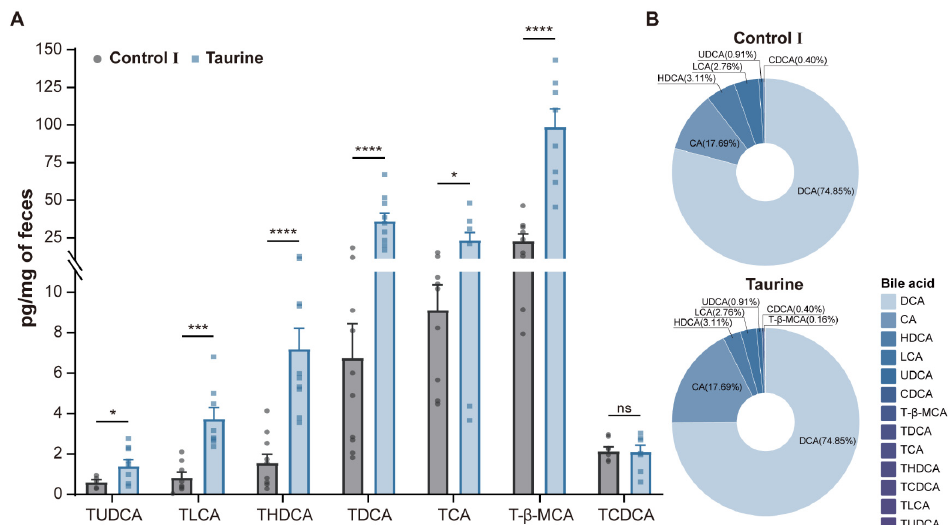
Figure 3. Changes in the bile acid metabolism after taurine supplementation. ( A ) Relative levels of bile acid species. ( B ) Composition of bile acids in feces. Data are presented as the means ± SEM (n = 8). * p < 0.05, *** p < 0.001, **** p < 0.0001, and p > 0.05 = not significant (ns) by unpaired two-tailed